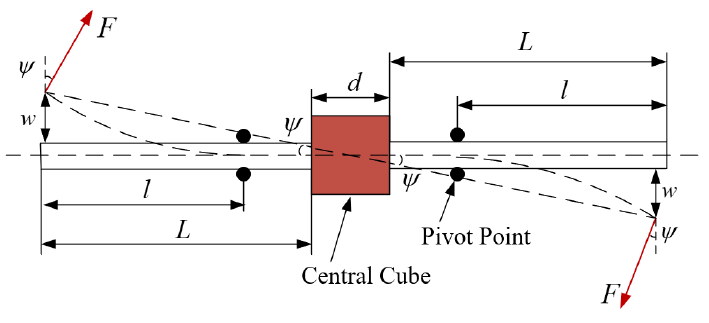
Figure 4. Sti ff ness adjustment schematic diagram of Figure 4. Stiffness adjustment schematic diagram of SCM-VSJ.